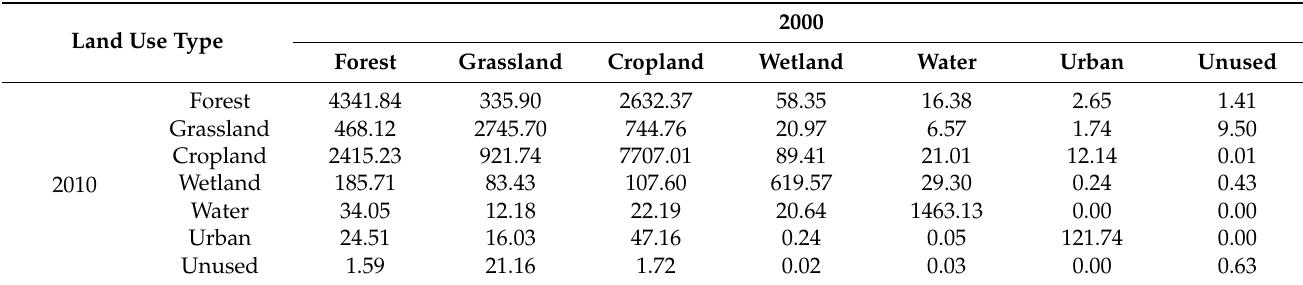
Table A3. Transfer matrix of land use types in Rwanda from 2000 to 2010 (km 2 ).